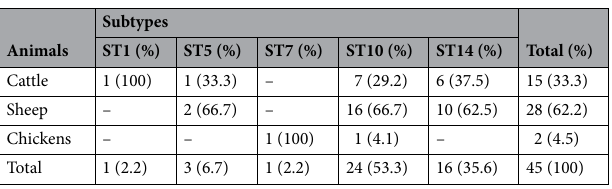
Table 4. The prevalence of Blastocystis sp., subtype in studied